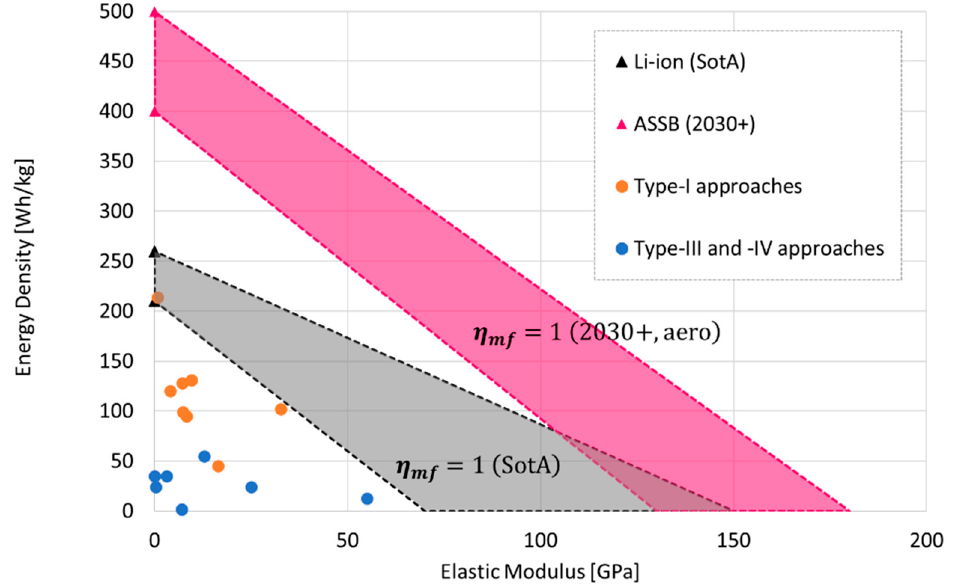
Figure 13. Specific energy vs. elastic modulus plots of structural batteries, as reported in the literature (complied from data reported in [11,23]) and structural battery targets: SotA (grey area) and for aeronautic applications in 2030+ (pink area).